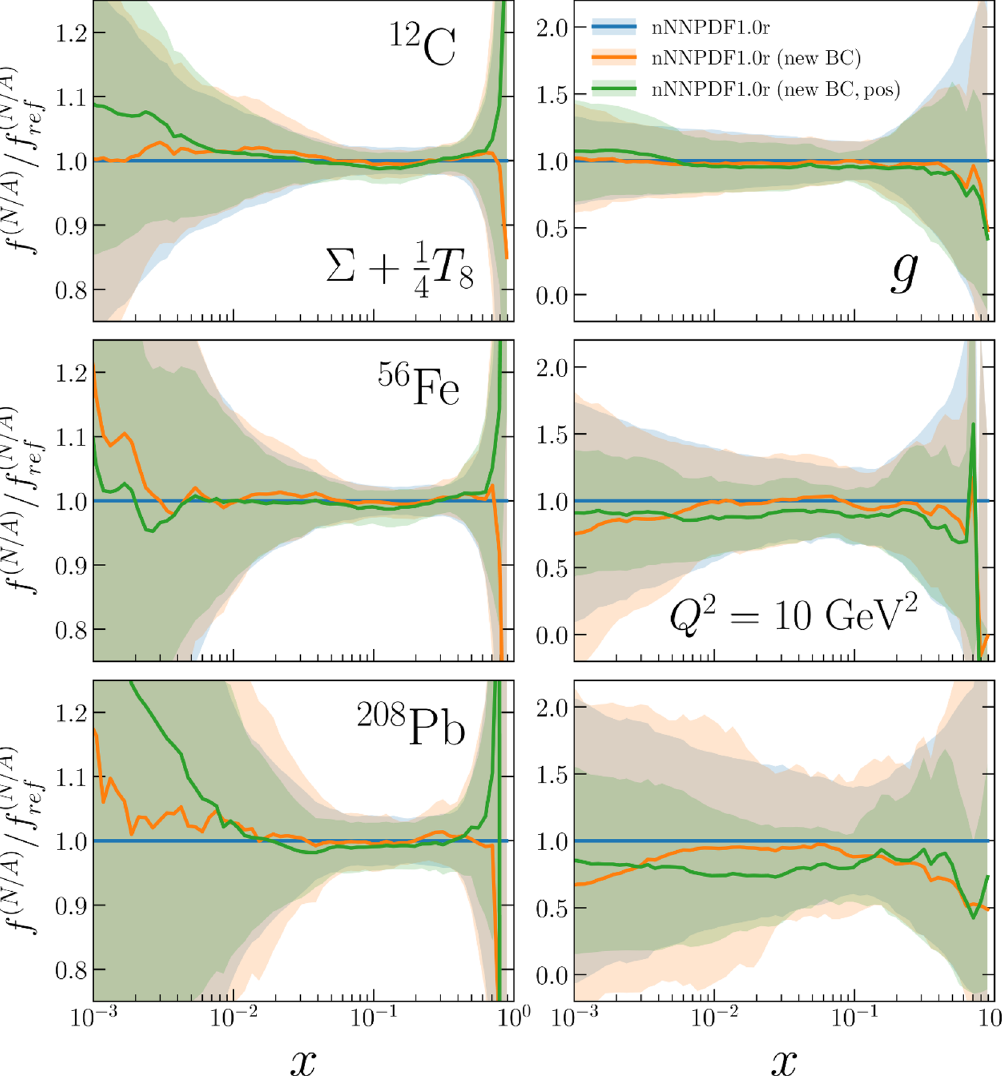
Figure 16 . Comparison between the nNNPDF1.0r baseline and two (cid:12)t variants based on the same input dataset, one where the proton boundary condition has been updated and another where in addition the positivity of physical cross-sections has been imposed. We show the (cid:6) + T 8 = 4 quark combination (left) and gluon (right) at Q 2 = 10 GeV 2 for three values of A .